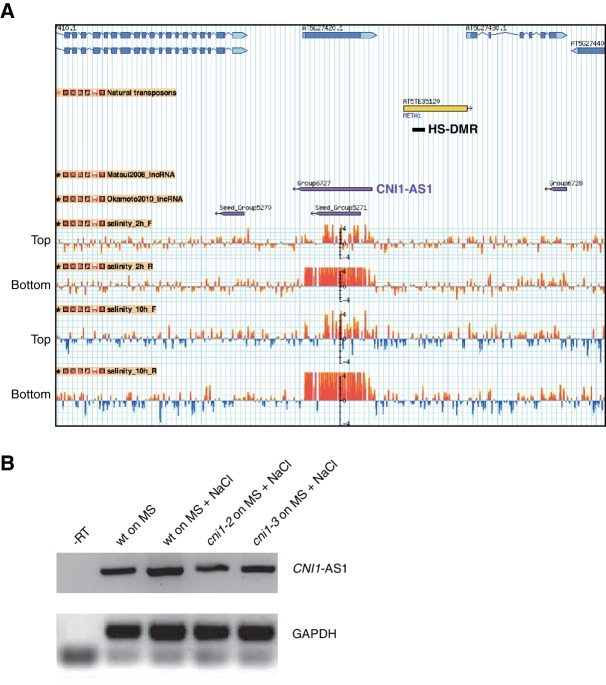
Expression analysis of CNI1 antisense lncRNA transcripts in response to hyperosmotic stress.(A) Genome browser view of the genomic region flanking CNI1 (At5g27420). Tracks represent gene annotations (blue), transposons (yellow) and HS-DMR (black), lncRNAs (purple) and normalised signal of tilling arrays hybridized with labelled RNA extracted from plants exposed to 125 mM NaCl for 2 and 10 hr (red and blue bars). Signal corresponding to top and bottom strands are indicated (Jin et al., 2013). (B) CNI1 antisense lncRNAs expression (RT-PCR) after exposure to hyperosmotic stress. NaCl, 125 mM NaCl.